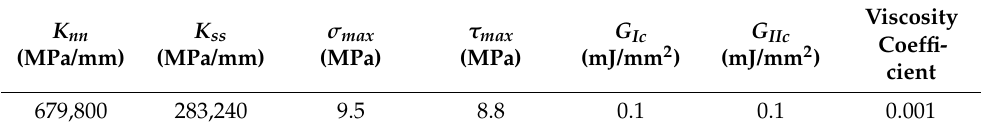
Table 4. Cohesive parameters used to model SiC deposition in DZC.